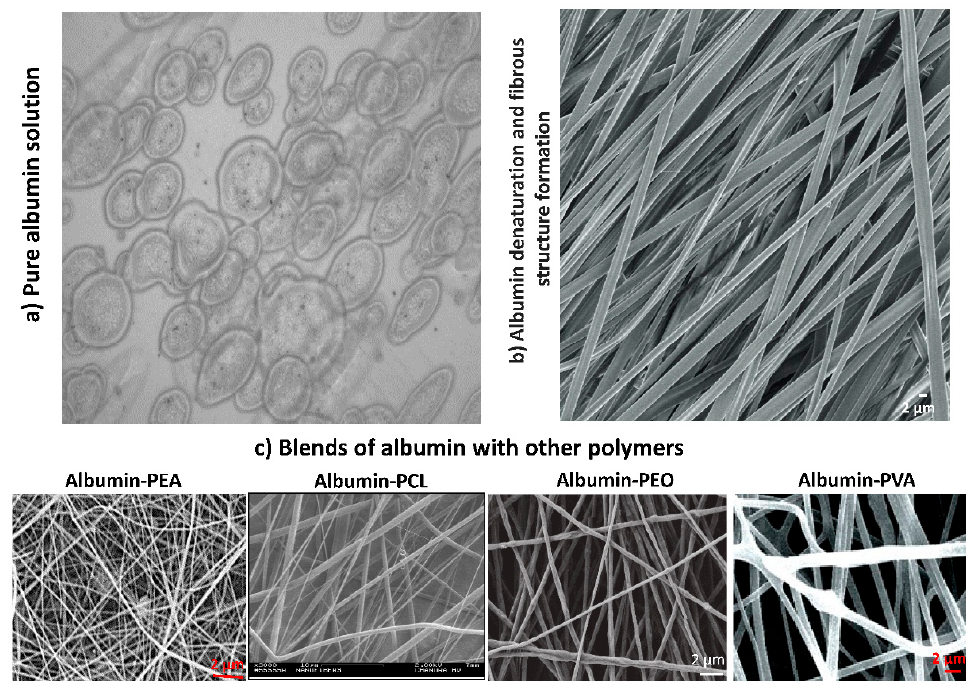
Figure 5. Electrospinning of albumin. ( a ) Inverted microscope image showing electrosprayed droplets from electrospinning of a pure albumin solution (unpublished image from the authors’ lab). ( b ) Denaturing solvents and reducing agents transform the albumin structure into electrospinnable fibrous structures [57]. ( c ) Electrospinning albumin into nanofibers can be achieved with polymers such as PEA (the SEM image contains unpublished data from the authors’ lab), Albumin-PCL [69], Albumin-PEO [61], and Albumin-PVA [67]. PEA: poly(ester amide), PCL: polycaprolactone, PEO: Polyethylene oxide, PVA: polyvinyl alcohol. Images from the cited references are used by permission.